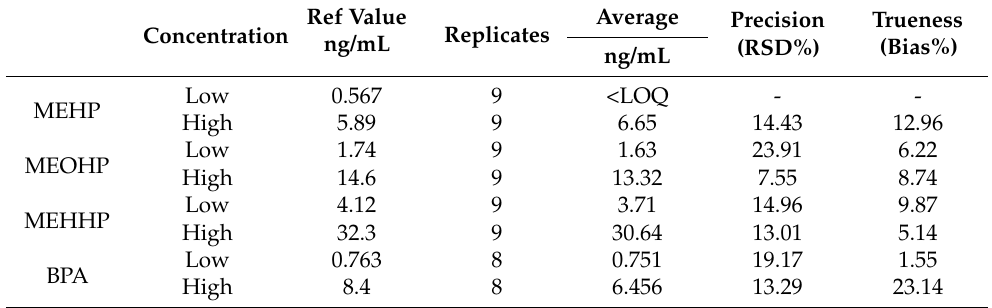
Table 5. Quantification of DEHP metabolites and BPA in 2 reference samples with low and high concentration of metabolites; replicates were measured for DEHP metabolites and 8 for BPA and the average was reported. RDS%= relative standard deviation; LOQ= limit of